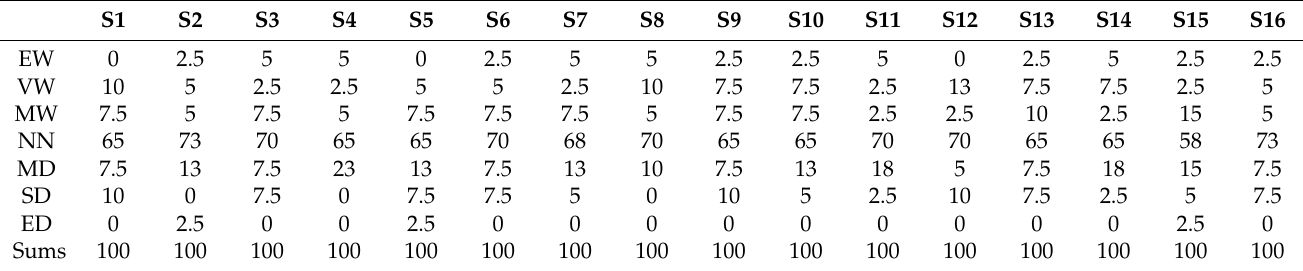
Table 6. Frequency of each drought and wetness class for the considered stations,